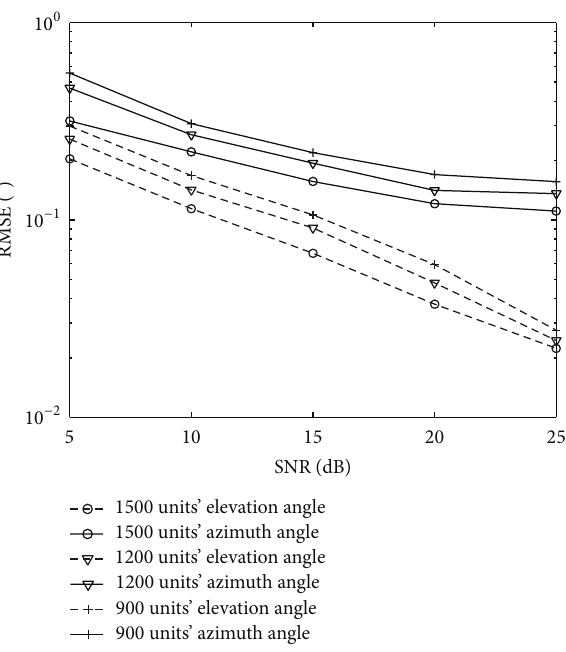
Figure 5: RMSE versus SNR with different elements by FPC-ROOT